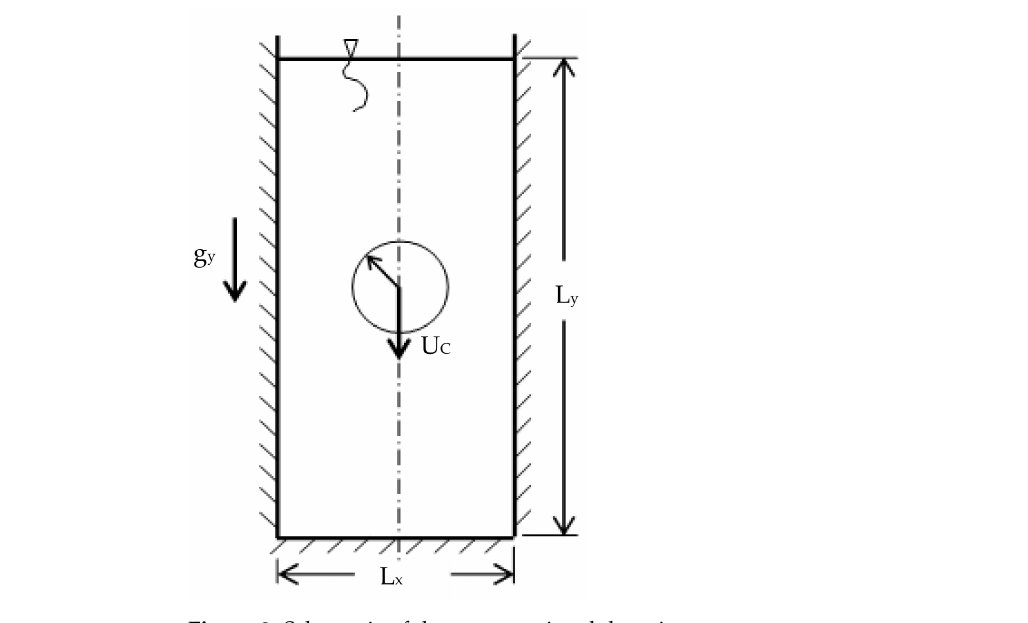
Table 1. List of the considered averaging options for density and viscosity.